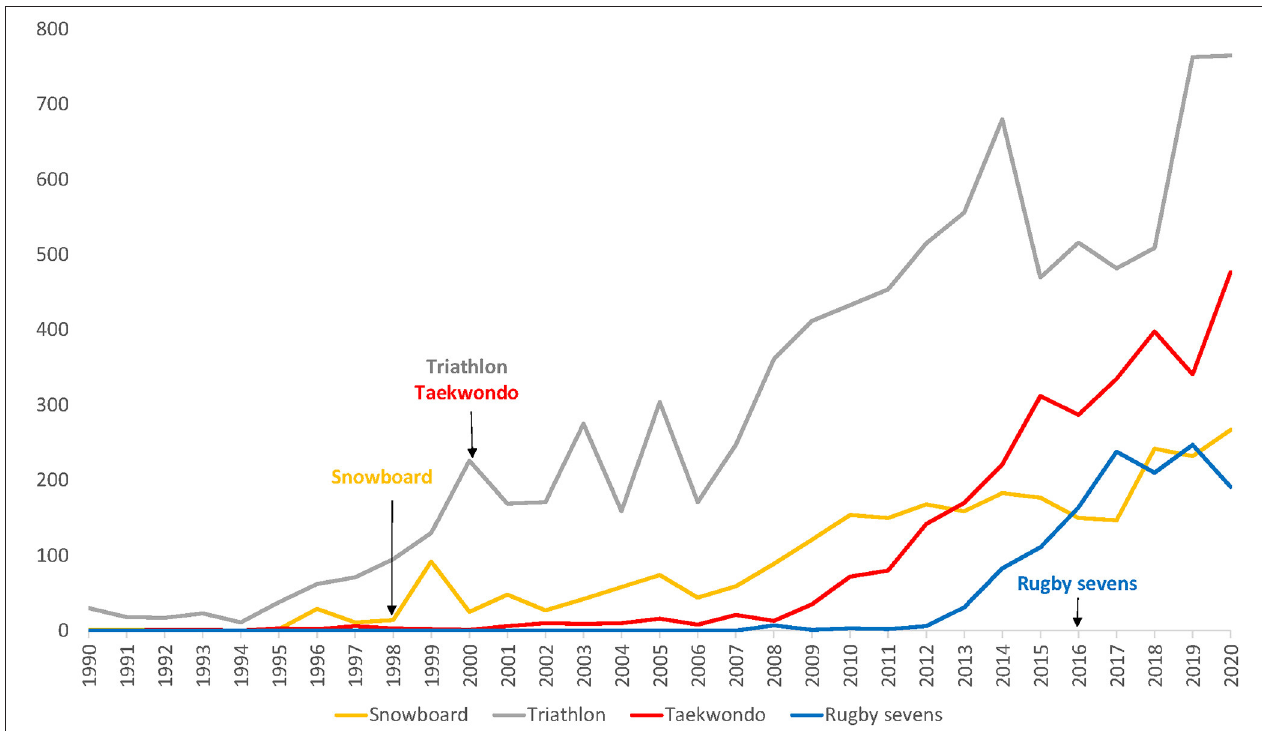
FIGURE 2 | Number of citations per year (y-axis) in four “recent” (i.e., debut at 1998 or later) Olympic sports. The date of the Olympic debut is marked by an